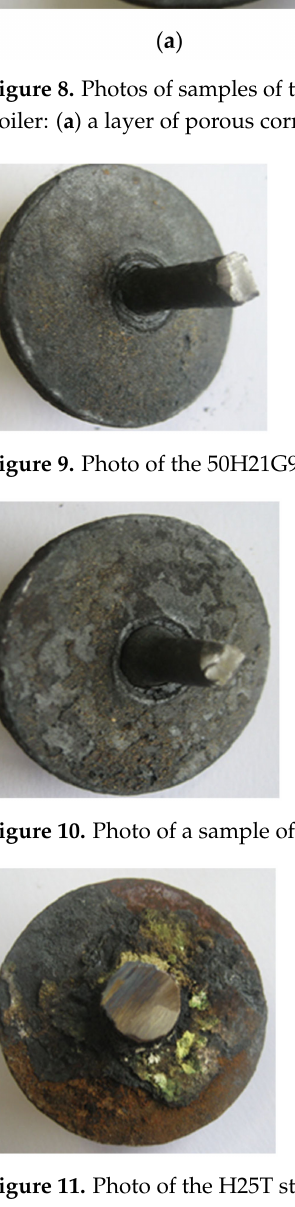
Figure 11. Photo of the H25T steel sample after exposure in the boiler combustion